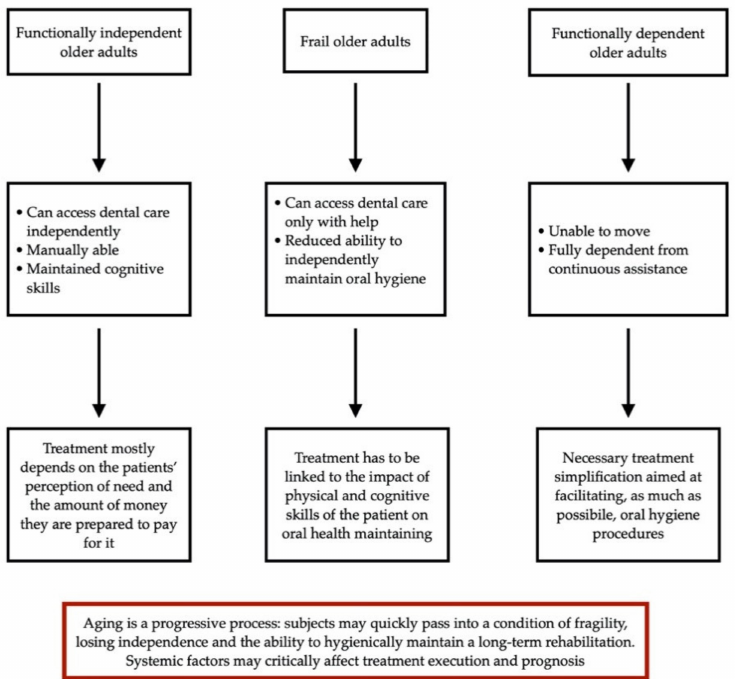
Figure 1. Flow chart of decision-making for older adults starting from Ettinger and Beck